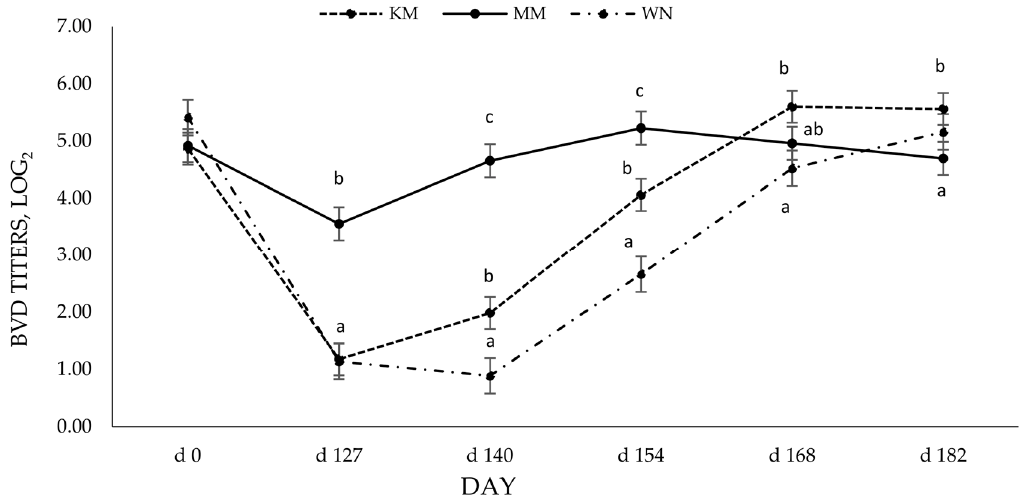
Figure 2. Least square means Log2 BVD antibody titers for treatment × day interaction in calves vaccinated with either an inactivated or modified-live viral BRD vaccine. Vaccines were administered for KM at d 0 (KV) and 127 (MLV), MM at d 0 (MLV) and 127 (MLV), and WN on d 127 (MLV) and 140 (MLV). KV = killed vaccine (ViraShield 6, Elanco Animal Health, Greenfield, IN). MLV = modified-live viral vaccine (Titanium 5, Elanco Animal Health, Greenfield, IN). a–c Least square means with differing superscripts differ by p < 0.05.